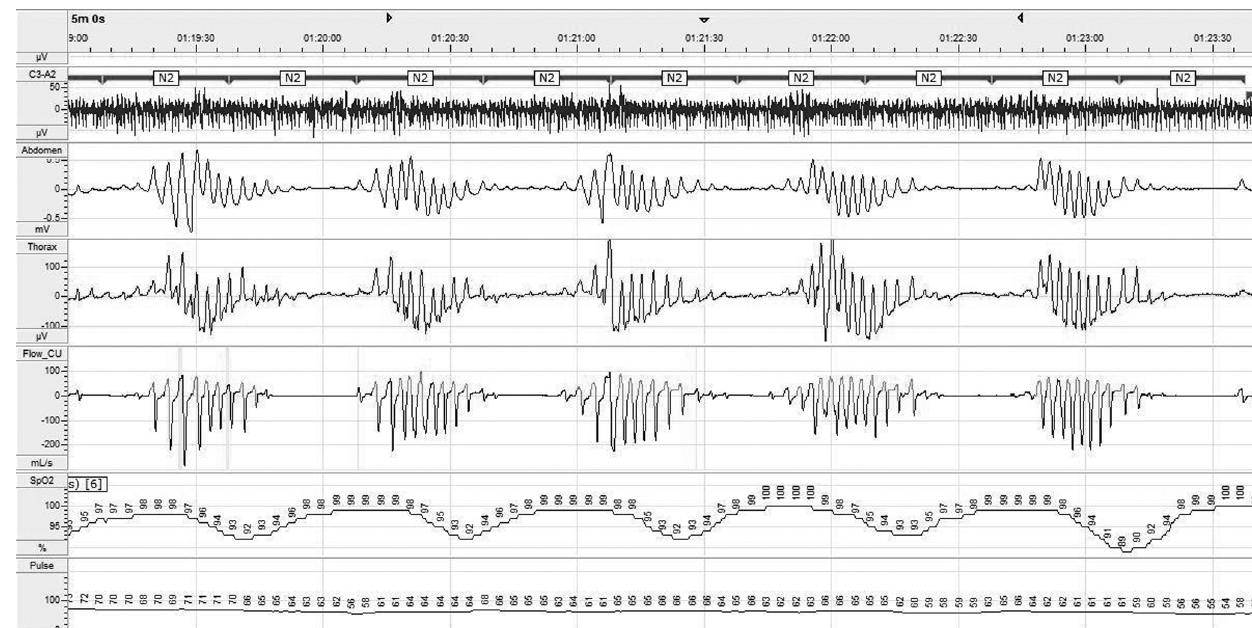
Figure 1 - Polysomnographic recording (5 minutes tracing) of an HCM patient with normal left ejection fraction presenting a Cheyne- Stokes respiration during sleep. The patient was on stage 2 sleep; top channel is related to sleep recordings. r The following channels, from top to bottom, trac respiration by monitoring motion of the thorax, abdomen, respiratory flow (nasal canulla), ear lobe oxymetry, and derived heart rate. Black arrows show how the circulation time is measured (time from the first breath after a central apnea to the subsequent nadir of SaO 2 detected at the ear by